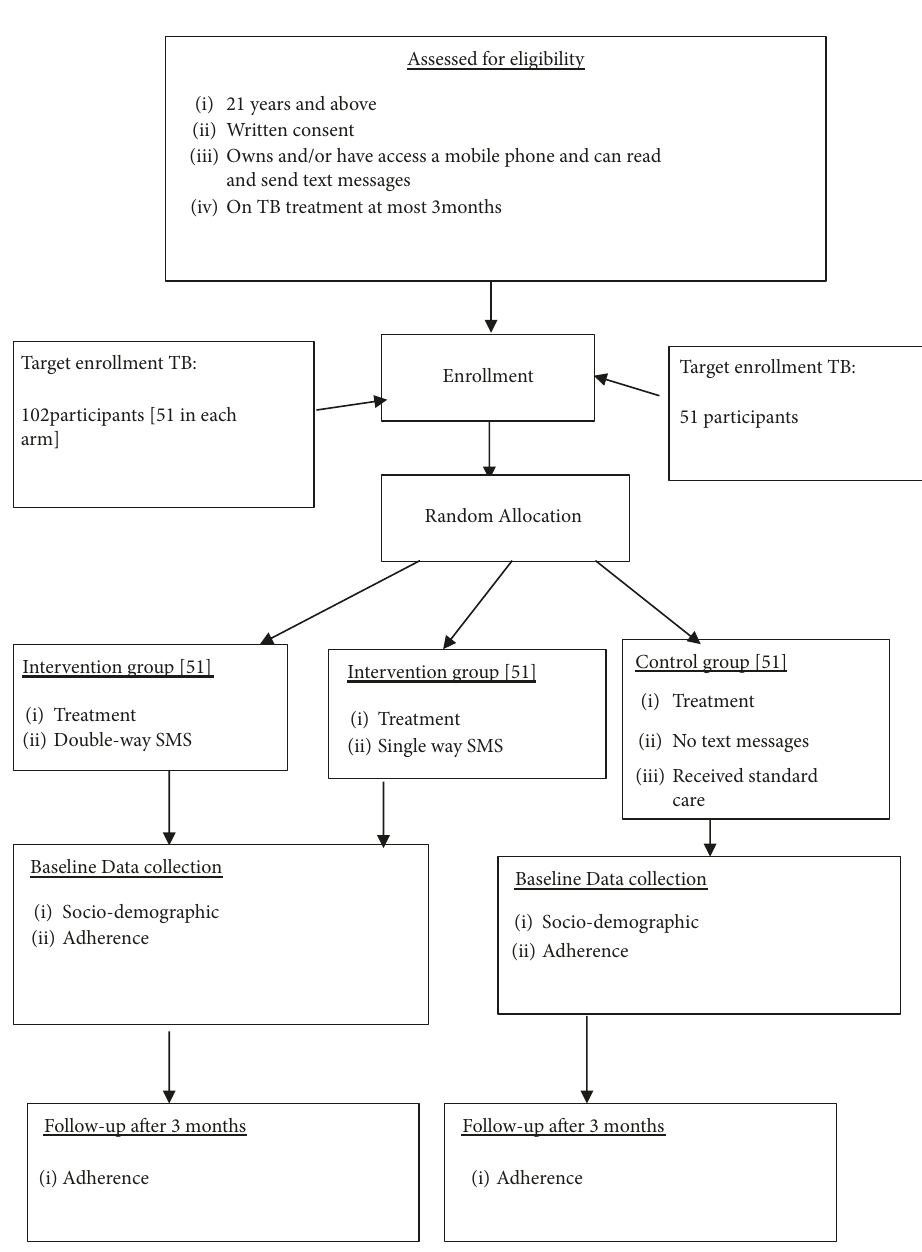
Figure 1: Flow chart showing recruitment and random allocation of the TB participants in the intervention and control